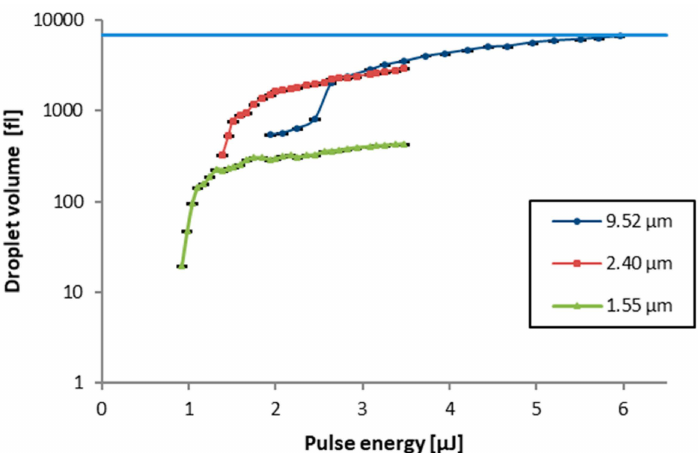
Figure 7. Volume of the transferred droplets as a function of the pulse energy E p of the inducing laser pulse for 3 different liquid donor film thicknesses d PI . Process parameters: λ = 515 nm, gap between donor and receiver d G = 200 µ m, and polyimide film thickness d PI = 3.5 µ m. Data points are connected by lines to guide the eye. The horizontal line indicates the maximum volume that could be transferred which correlates with cylinder volume with a diameter of 30 µ m (laser beam diameter) and the maximum investigated film thickness (9.52 µ